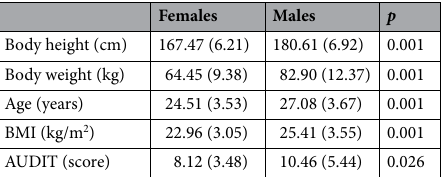
Table 1. Participants’ characteristics. n Female = 50, n Male = 50, descriptive data are presented as mean and standard